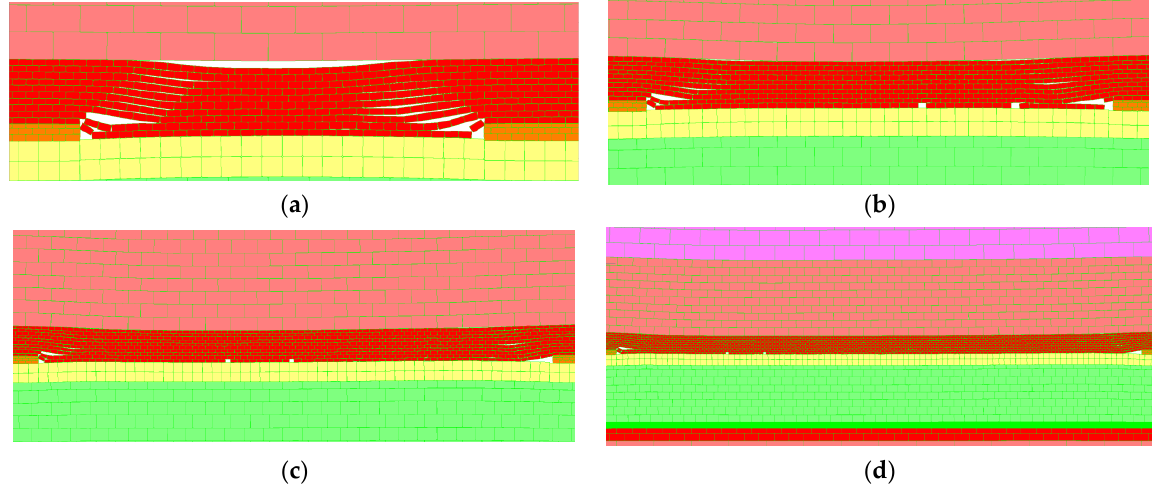
Figure 4. Caving characteristics of working face advancing at different distances: ( a ) collapse characteristics when the working face advances 30 m; ( b ) collapse characteristics when the working face advances 50 m; ( c ) collapse characteristics when the working face advances 80 m; and ( d ) collapse characteristics when the working face advances 140 m.